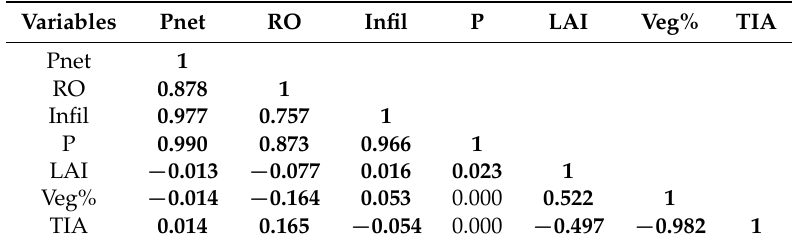
Table 2. Correlation matrix (Pearson) to approximate the volume of the 3 main surface processes: net precipitation (Pnet), surface runoff (RO), infiltration (Infil). Values in bold are different from 0 with a significance level alpha =